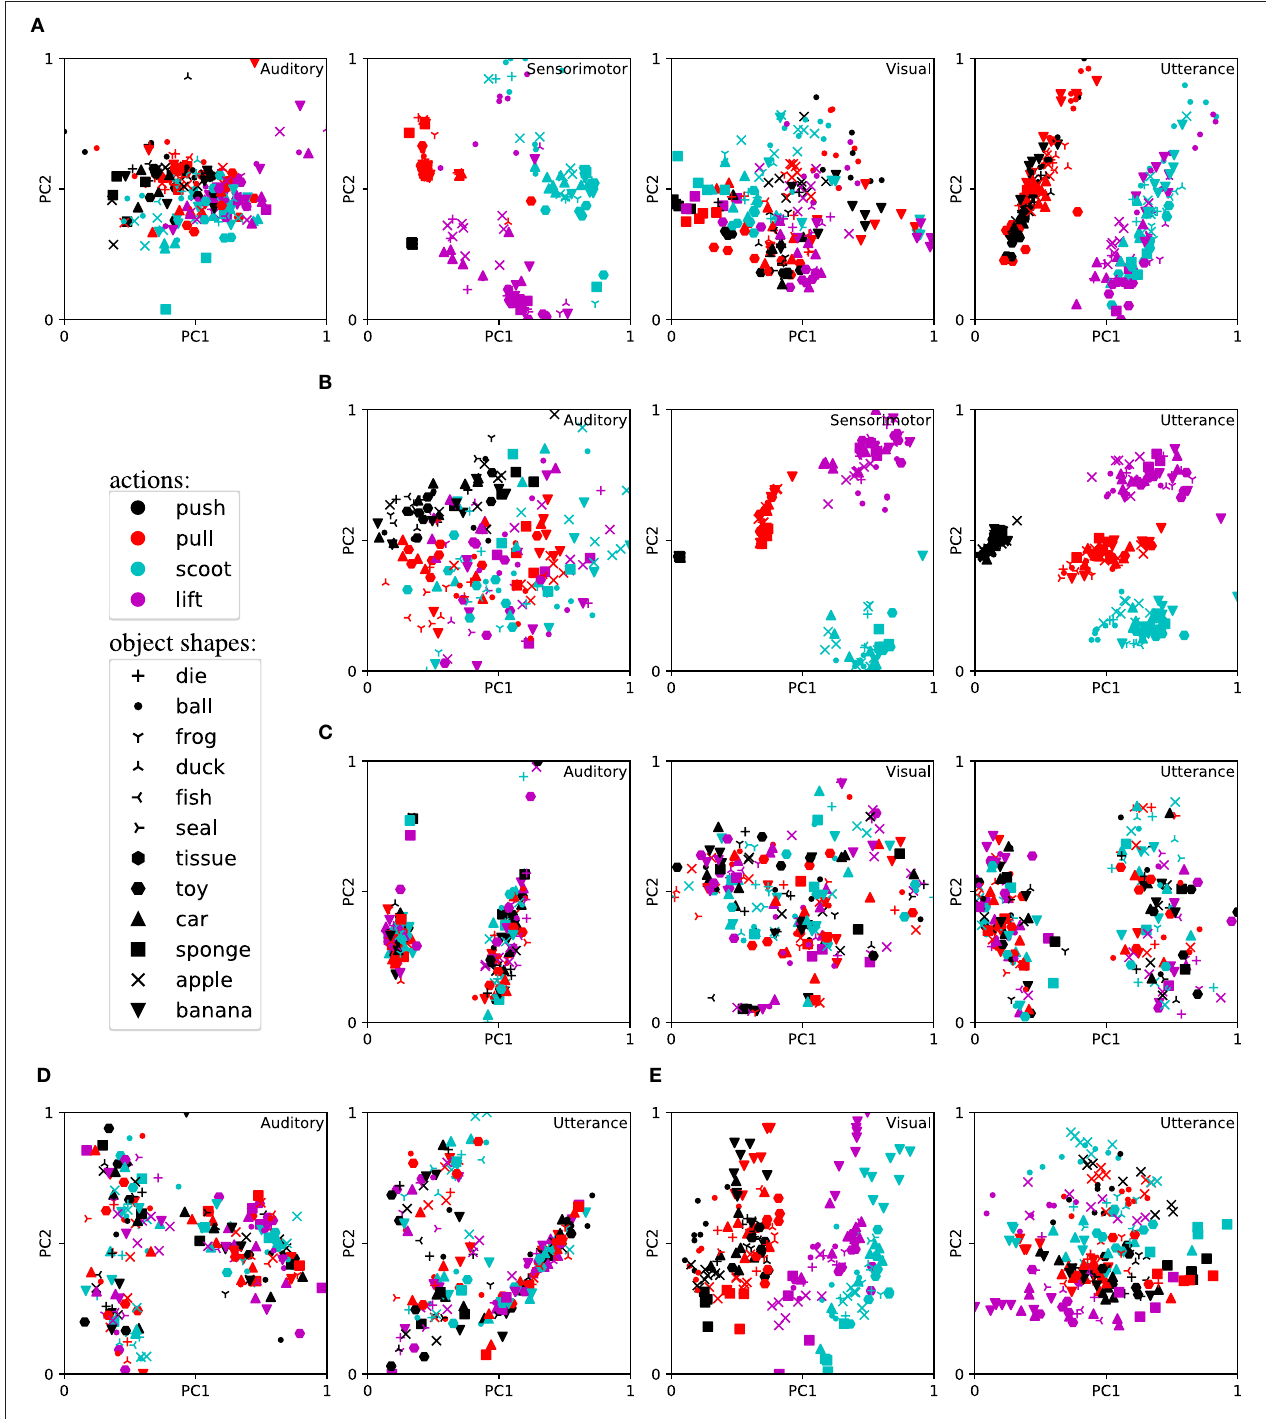
FIGURE 4 | Learned representations in the cell assemblies for training on different modalities (reduced by PCA to first the two principal components PC1 and PC2). (A) Perception via auditory, sensorimotor, and visual modalities. (B) Perception via auditory and sensorimotor modalities. (C) Perception via auditory and visual modalities. (D) Perception via auditory modality. (E) Perception via visual modality.